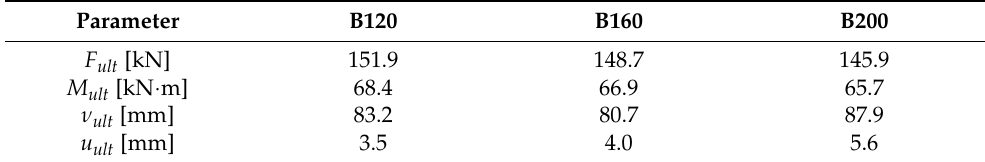
Figure 7. The load versus slip response for the B120, B160, and B200 beams. Table 3. The ultimate load ( F ult ), the ultimate load-carrying capacity ( M ult ), the deflection corre- sponding to the ultimate load ( ν ult ), and the slip corresponding to the ultimate load ( u ult ) from the bending tests.